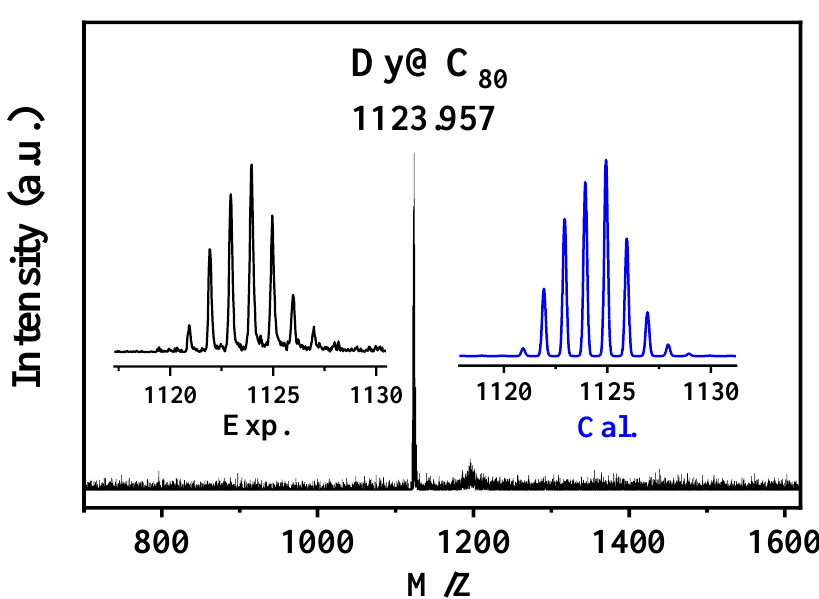
Figure 2. MALDI-TOF MS of the fraction A-2-2-2 with 1,1,4,4-tetraphenyl-1,3-butadiene as matrix.